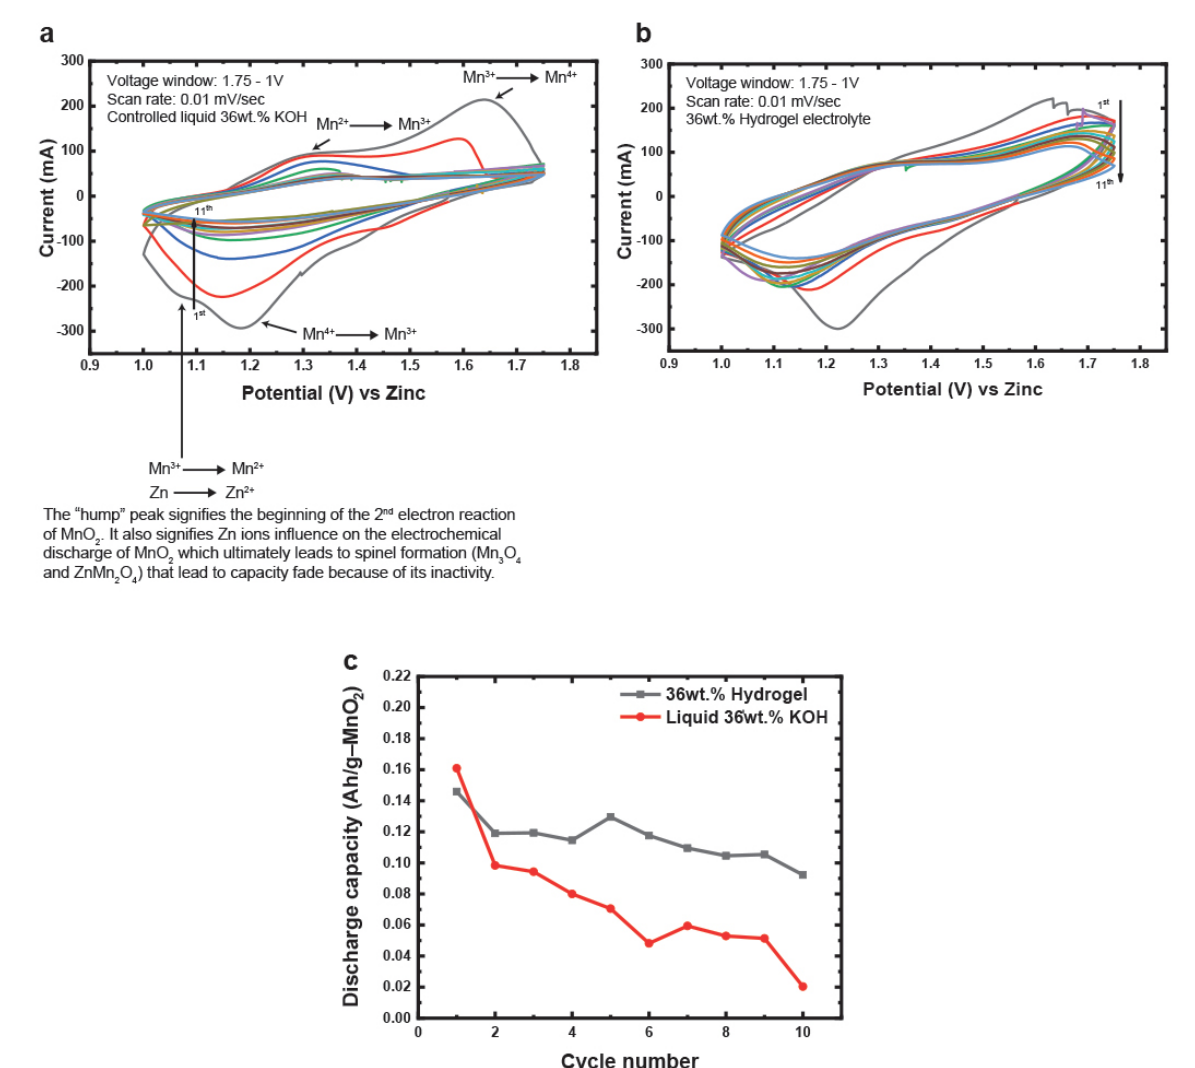
Figure 6. ( a ) Cyclic voltammetry curve of a Zn–MnO 2 cell containing liquid 36 wt.% KOH scanned at 0.01 mV/s between 1.75 V and 1 V. ( b ) Cyclic voltammetry curve of a Zn–MnO 2 cell containing hydrogel 36 wt.% KOH scanned at 0.01 mV/s between 1.75 V and 1 V. ( c ) Capacity retention comparison of Zn–MnO 2 cells containing either liquid or hydrogel 36 wt.% KOH.